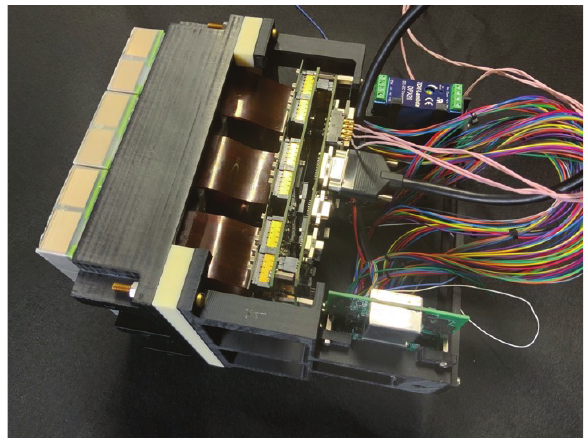
Figure 5. JEM-EUSO’s last generation